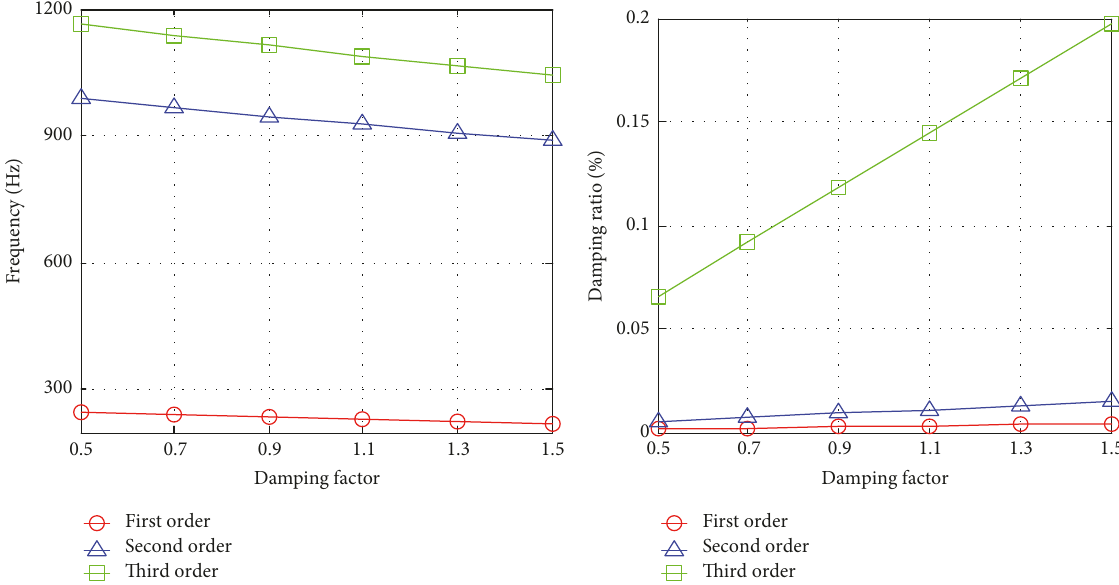
Figure 9: Natural frequencies and modal damping ratio of the blade under the influence of loss factor.